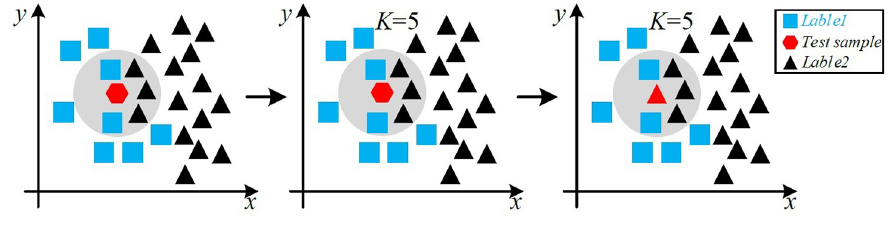
Fig 5. Majority voting